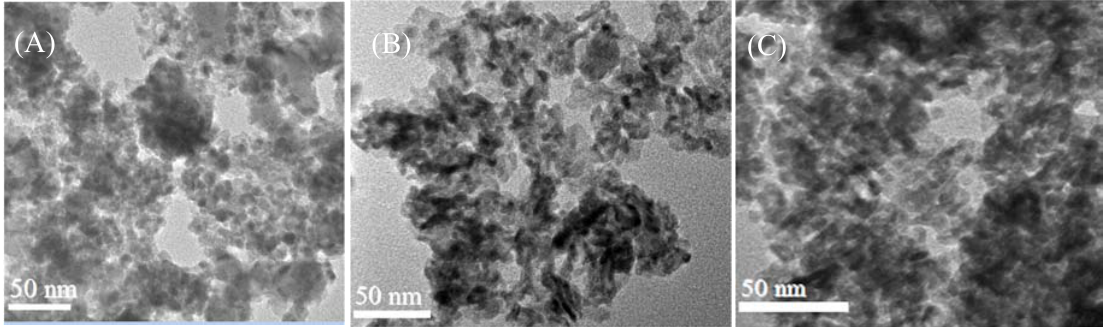
Figure 3. TEM images of M/CeO 2 −δ samples. ( A ) Co/CeO 2 −δ ; ( B ) Ni/CeO 2 −δ and ( C ) Cu/CeO 2 −δ .